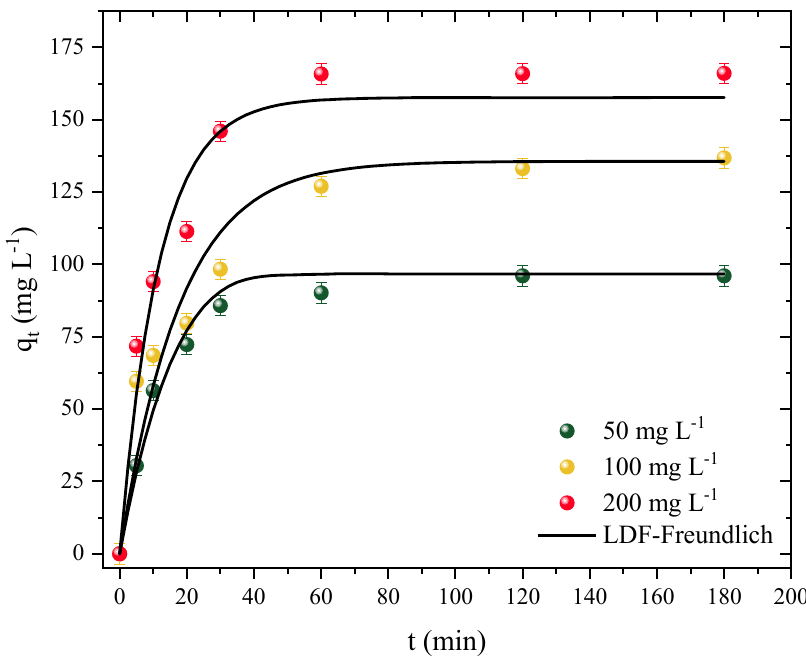
Figure 5. Diuron adsorption kinetic curves in CPAC (T = 298 K, D 0 = 0.5 g L − 1 , pH natural = 7, V = 25 mL).